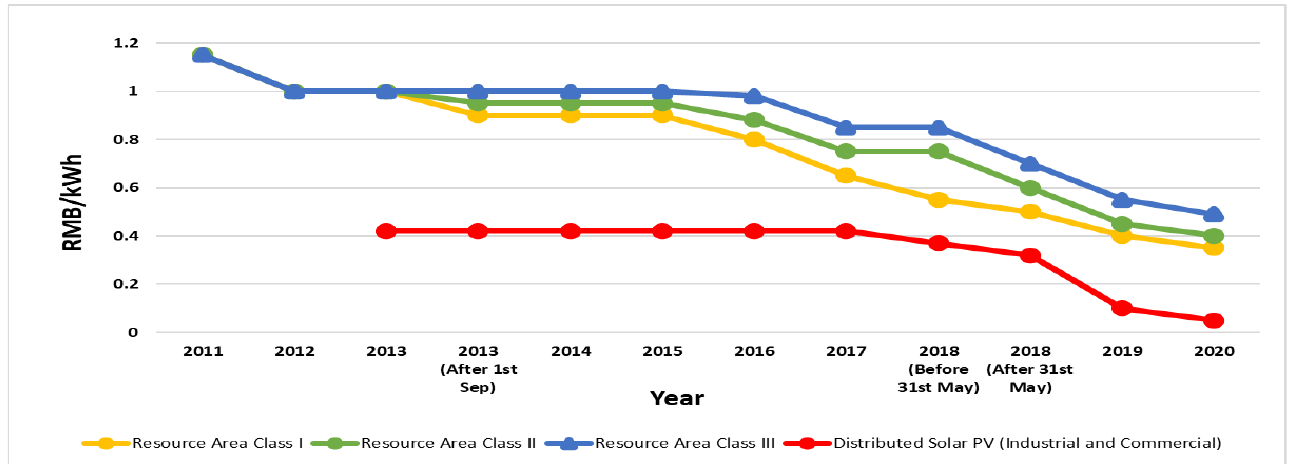
Figure 1. Feed-in tariff rates for wind power in China. Source: Xu (2019) [38].